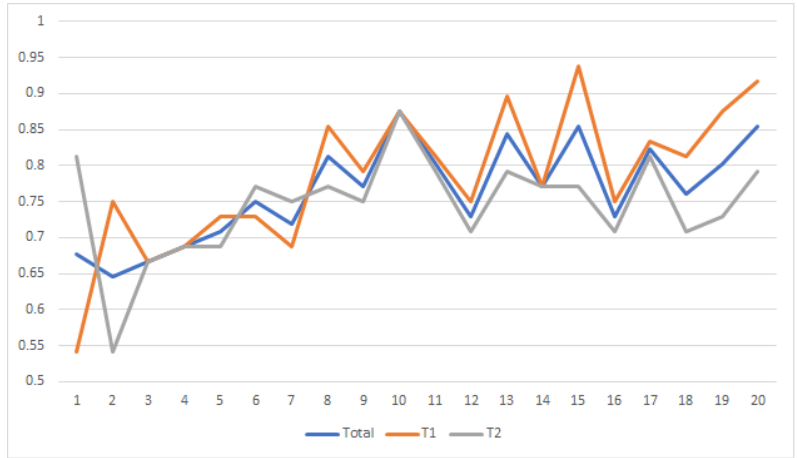
Figure 6. The Proportion of In Play over